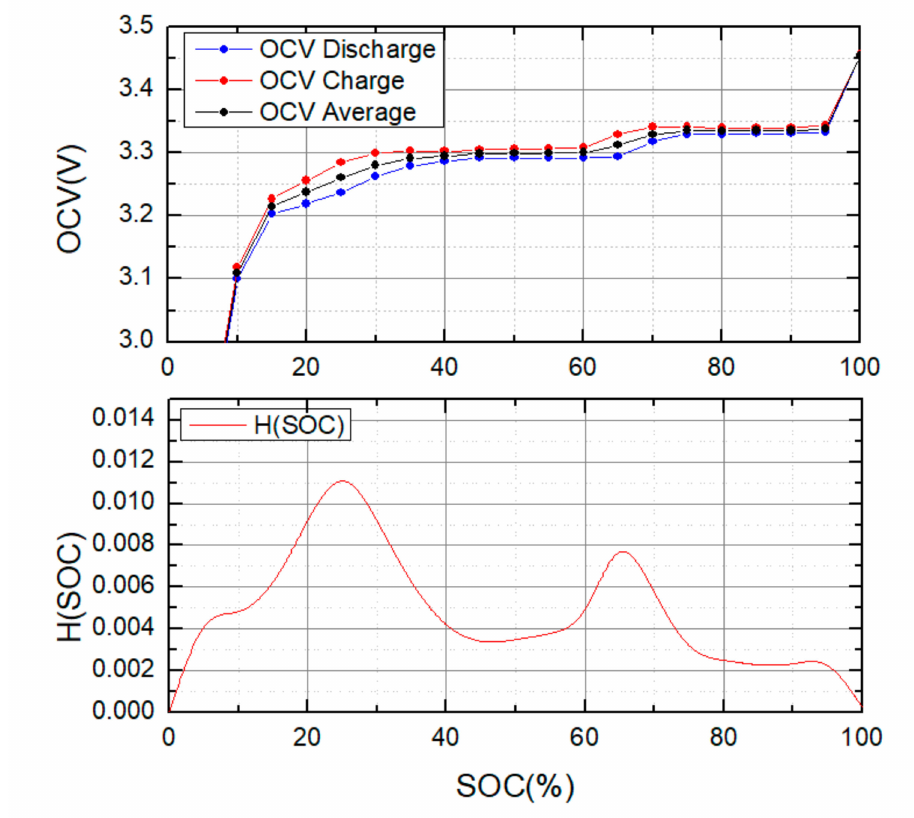
Figure 1. State of charge (SOC–OCV) curve of LiFePO4 and H(SOC) curve for one-state hysteresis modeling